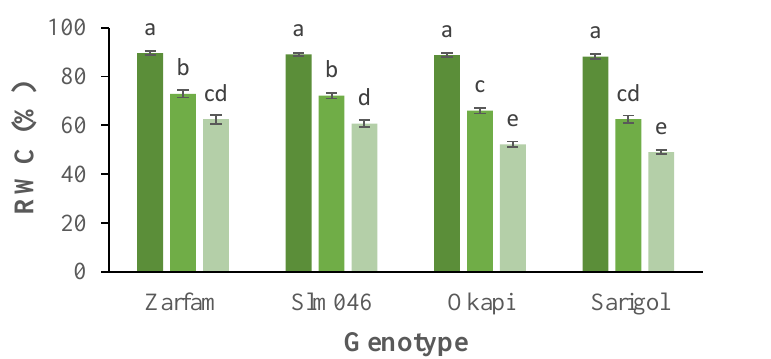
Figure 1. Interaction effect of drought stress and genotype on the relative water content (RWC) of canola leaves. Data are means ( n = 3) ± SE. Different letters indicate differences ( p < 0.05) among treatments according to the Duncan test.